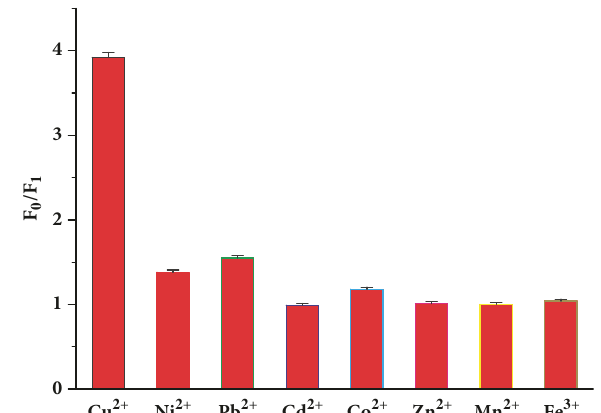
Figure 4: Fluorescence quenching effect of metal ions (F 0 and F 1 are the fluorescence intensity of the AuNCs-BSA in the absence and presence of metal ions,